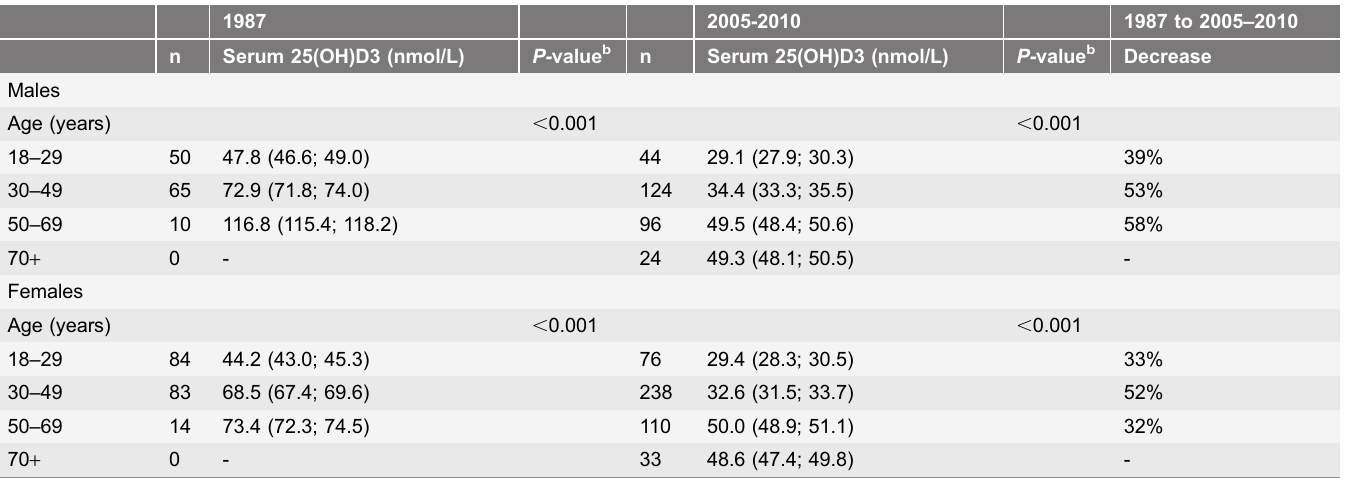
Table 1. Serum 25(OH)D3 (nmol/L) among 306 individuals examined in May-June 1987 and 745 individuals examined in May-June 2005–2010 by gender and age groups a .